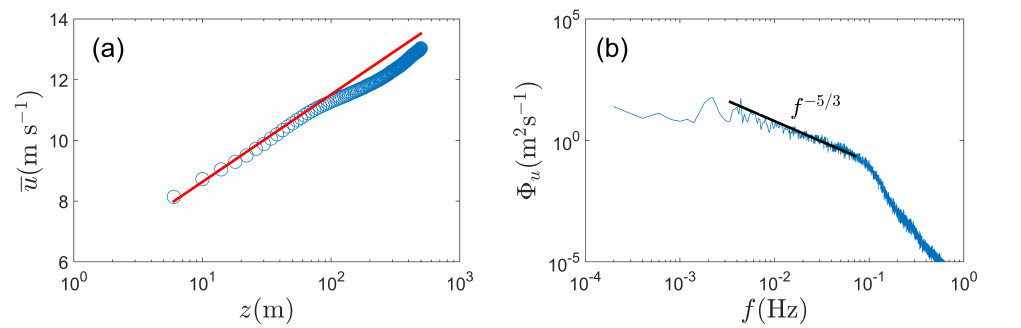
Figure 3. ( a ) Averaged boundary-layer profile with no turbines or windbreaks present. Blue markers indicate LES data, and red lines indicate a logarithmic boundary-layer profile; ( b ) Velocity power spectrum Φ u simulated at turbine hub height.